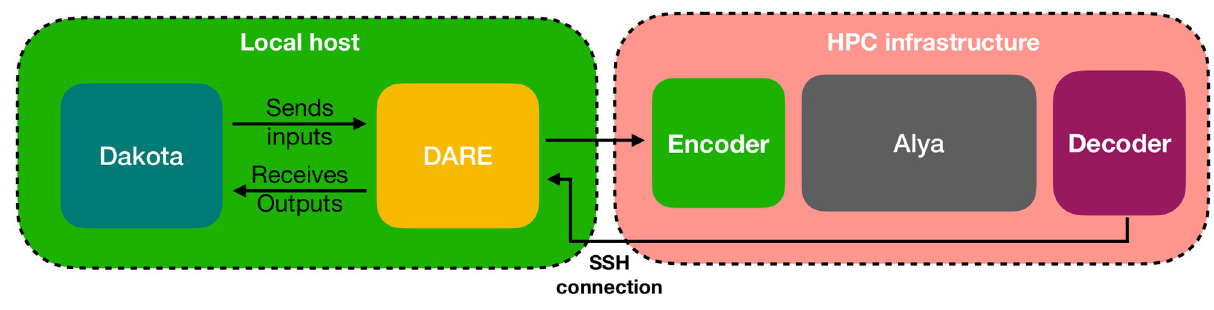
Fig 2. Scheme of DARE building